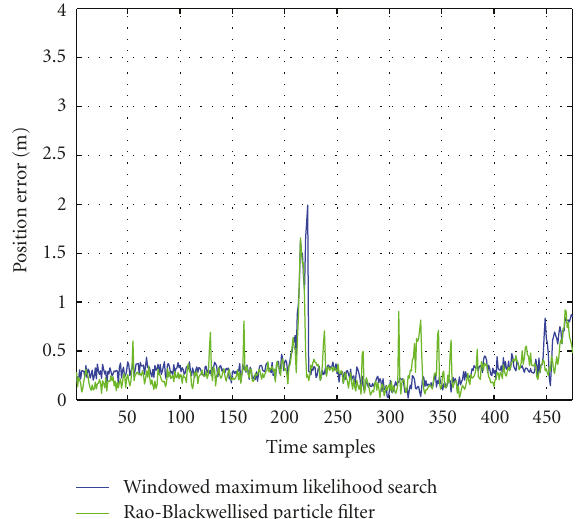
Figure 9: This figure shows the position errors of the vehicle’s RBPF MAP position estimate (in green) and the windowed ML search estimate (in blue) with optimal threshold, when compared with the true position of the vehicle.